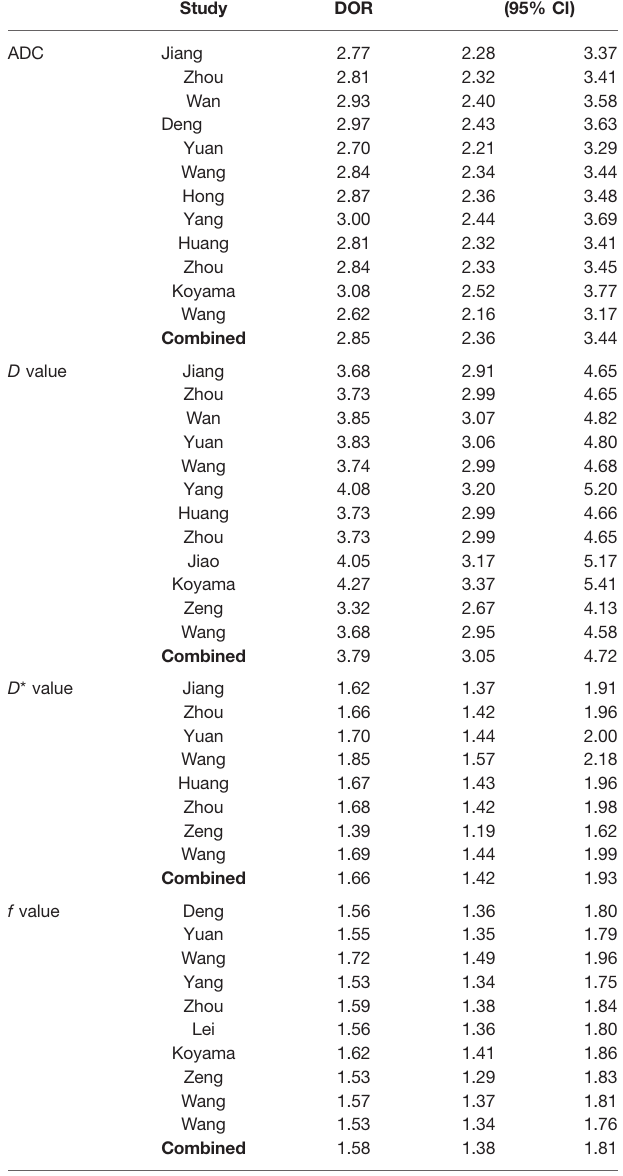
TABLE 4 | In fl uence of each study on the outcome of the meta-analysis. Study DOR (95% Cl) ADC Jiang